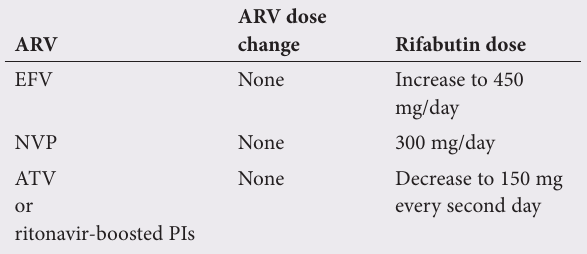
Table 8. Dosing of ARVs and rifabutin when prescribed